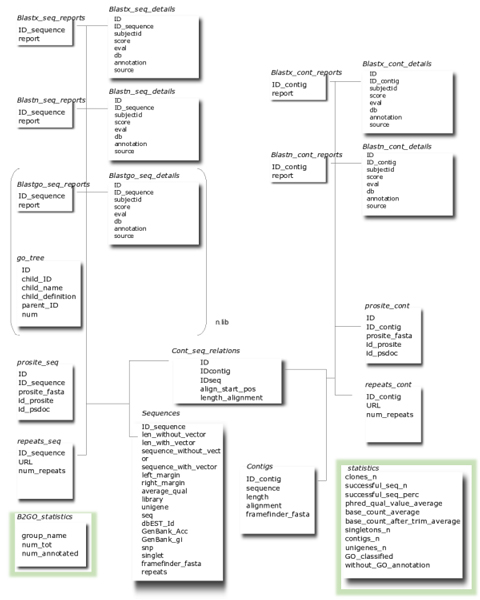
The ESTuber database. Main tables of the ESTuber db.